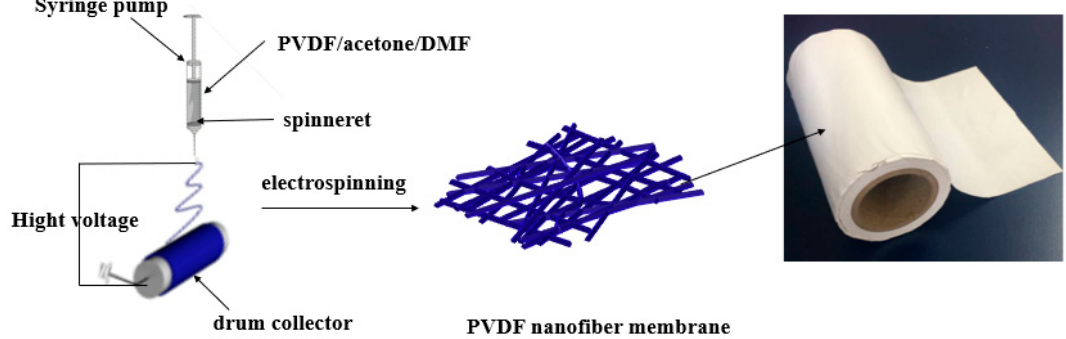
Figure 1. Schematic diagram illustrating the followed electrospinning process.